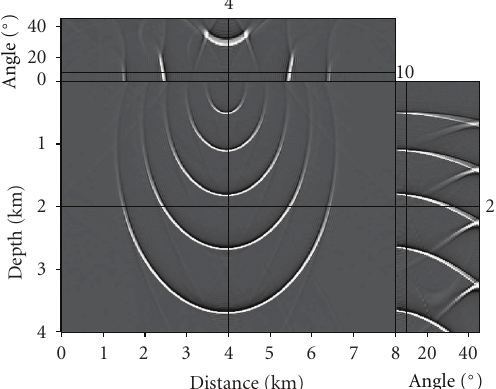
Figure 4: Prestack synthetic data generated using Kirchho ff mod- eling for the TTI model in Figure 3 with velocity (NMO and along the tilt) equals 2km/s and η = 0 . 2.